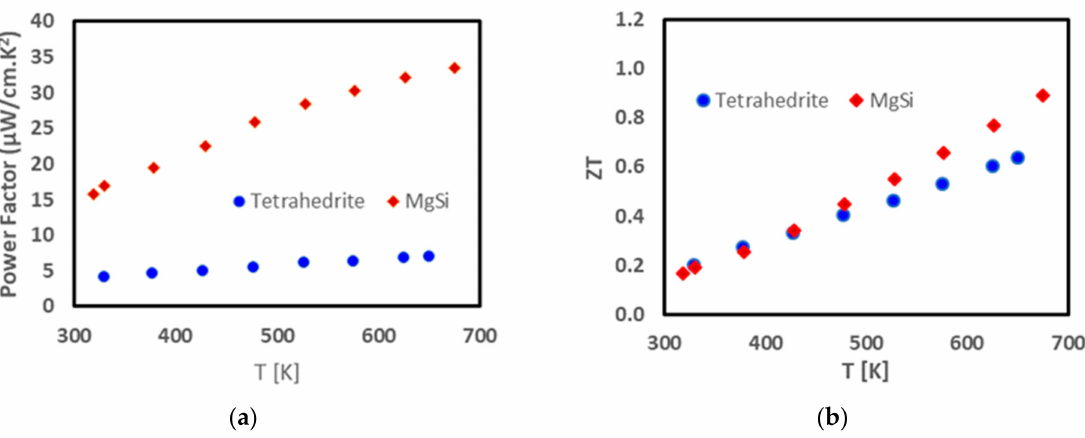
Figure 1. Material properties: ( a ) power factor and ( b ) zT (partially adapted from